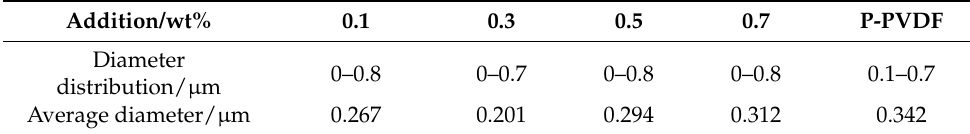
Figure 9. The fiber diameter distribution at different addition of AgNO 3 : ( a ) the addition of 0.1 wt%; ( b ) the addition of 0.3 wt%; ( c ) the addition of 0.5 wt%; ( d ) the addition of 0.7 wt%. Table 3. The average diameter of the fiber membrane at different loading of AgNO 3 .